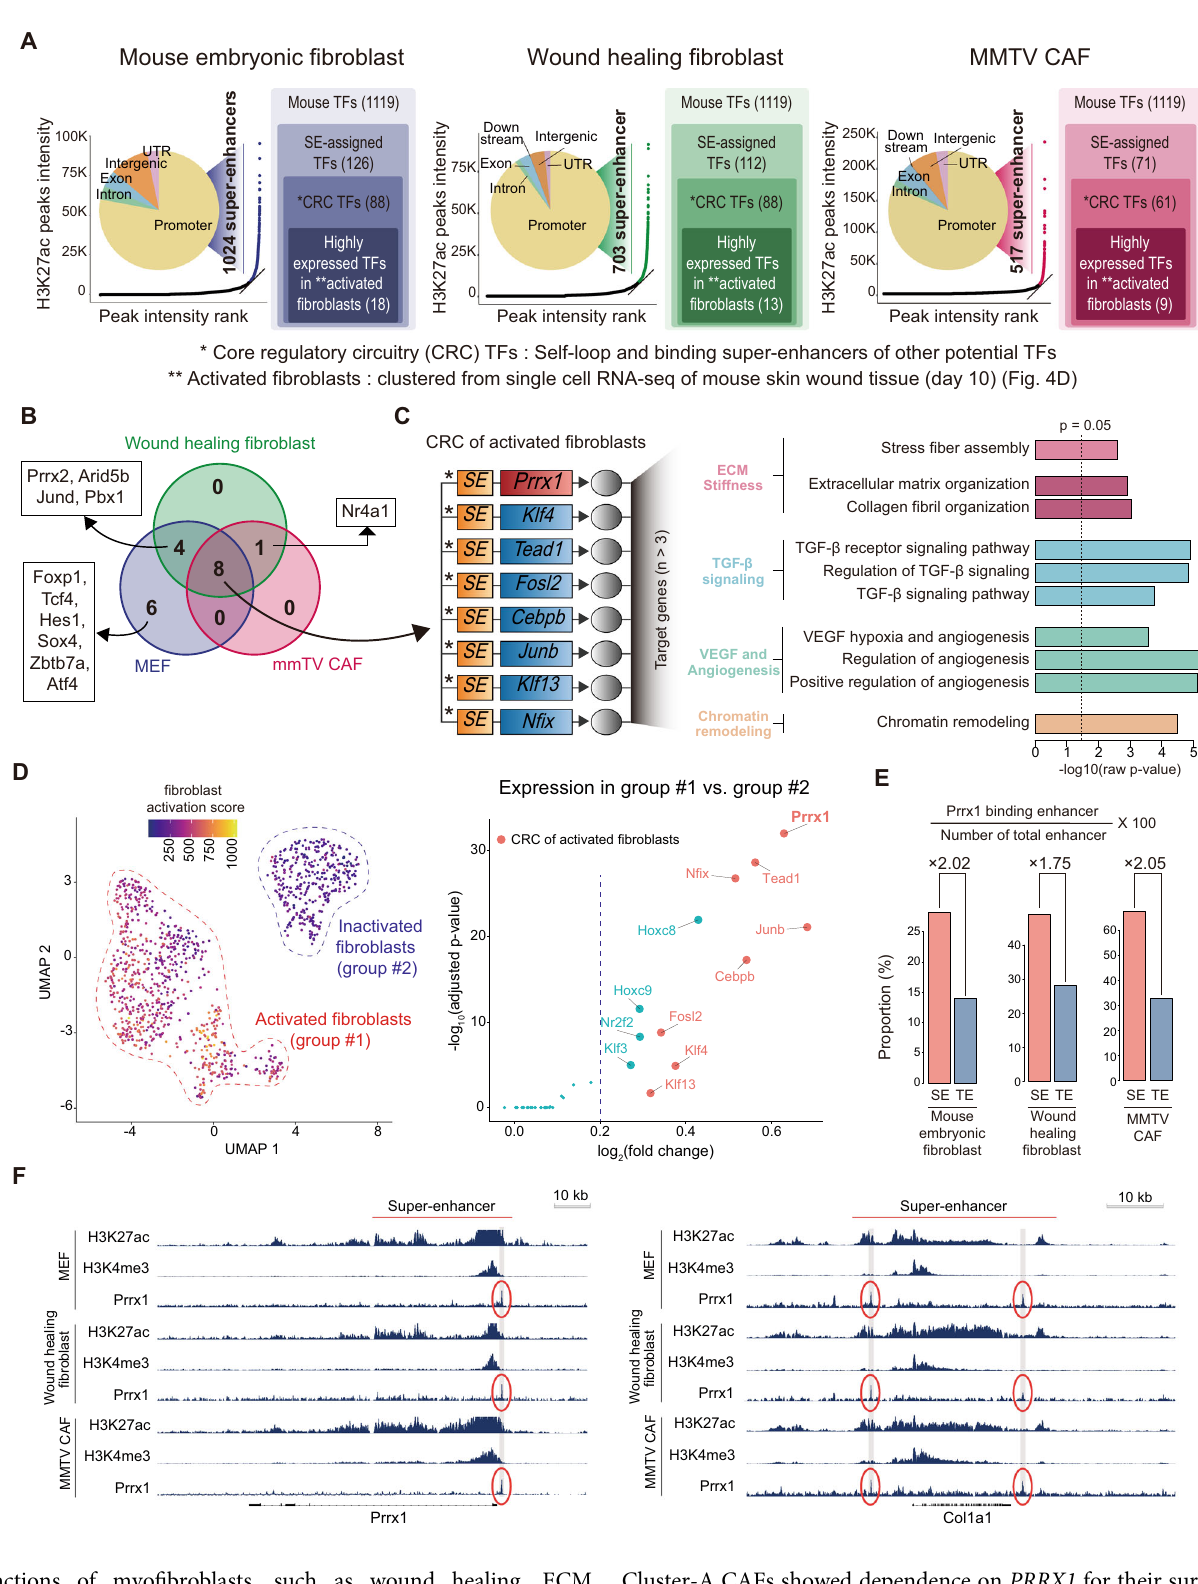
4D)* Core regulatory circuitry (CRC) TFs : Self-loop and binding super-enhancers of other potential TFs ** Activated fibroblasts : clustered from single cell RNA-seq of mouse skin wound tissue (day 10) (Fig.